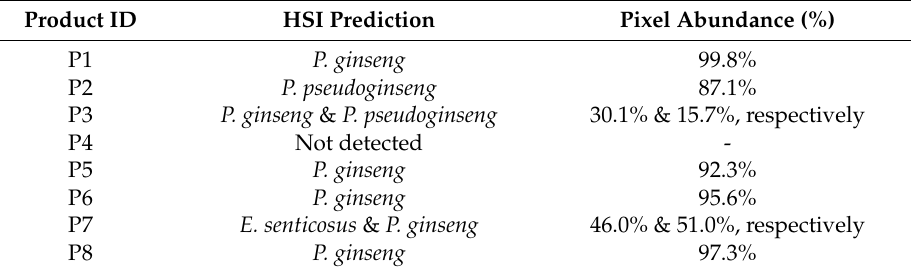
Figure 3. PLS-DA predictions for commercial products and authentic reference materials (test set) based on hyperspectral imaging data. Table 1. Classification of raw material constituents in commercial ginseng products as determined from predicted pixel abundance using the PLS-DA model based on HSI data.